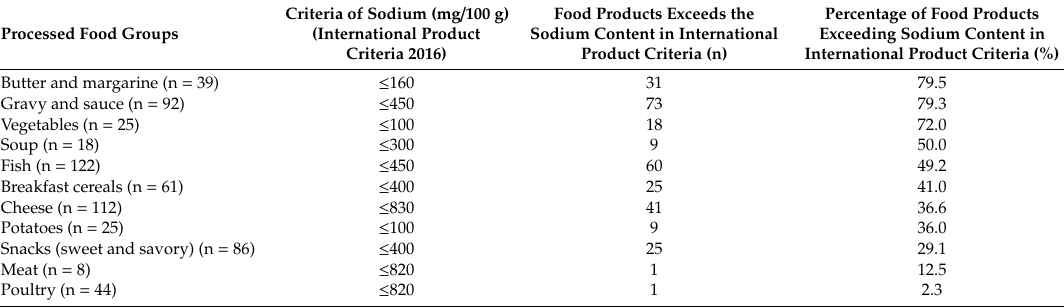
Table 4. Percentage of processed food products exceeding the sodium content in International Product Criteria